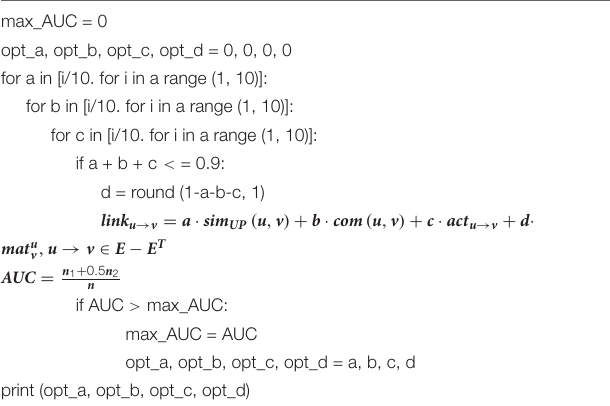
Algorithm 2 | The weight training algorithm of the FMLPM model.